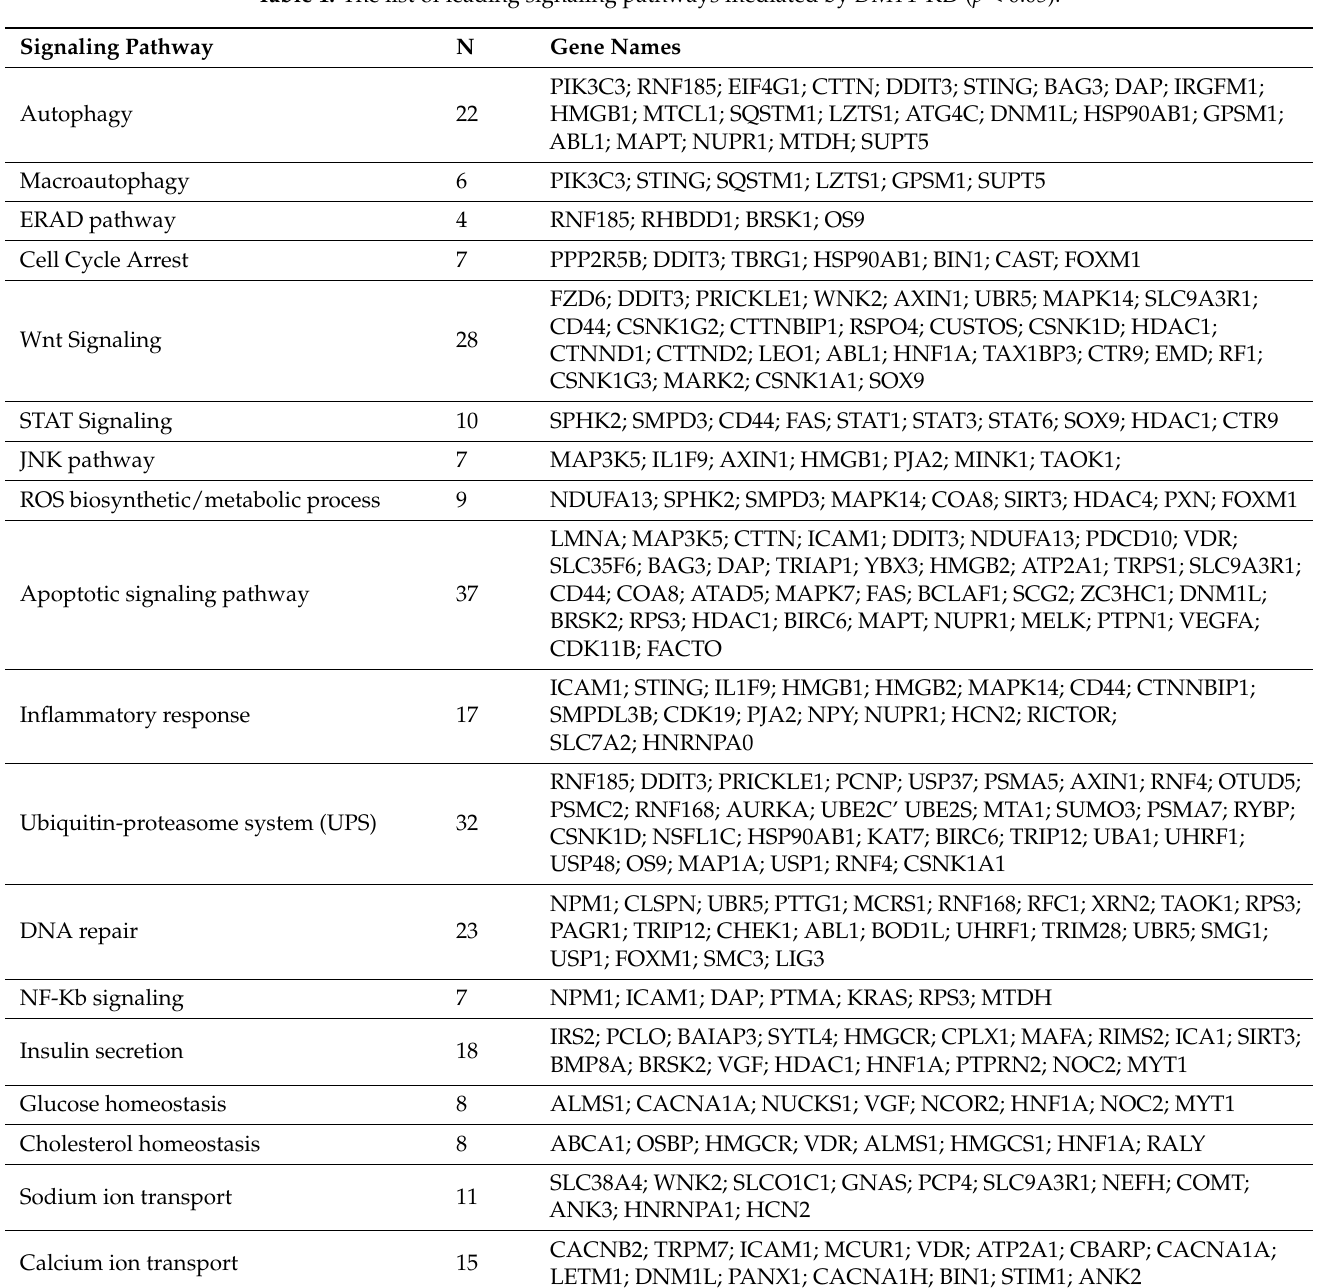
Table 1. The list of leading signaling pathways mediated by DMT1 -KD ( p <